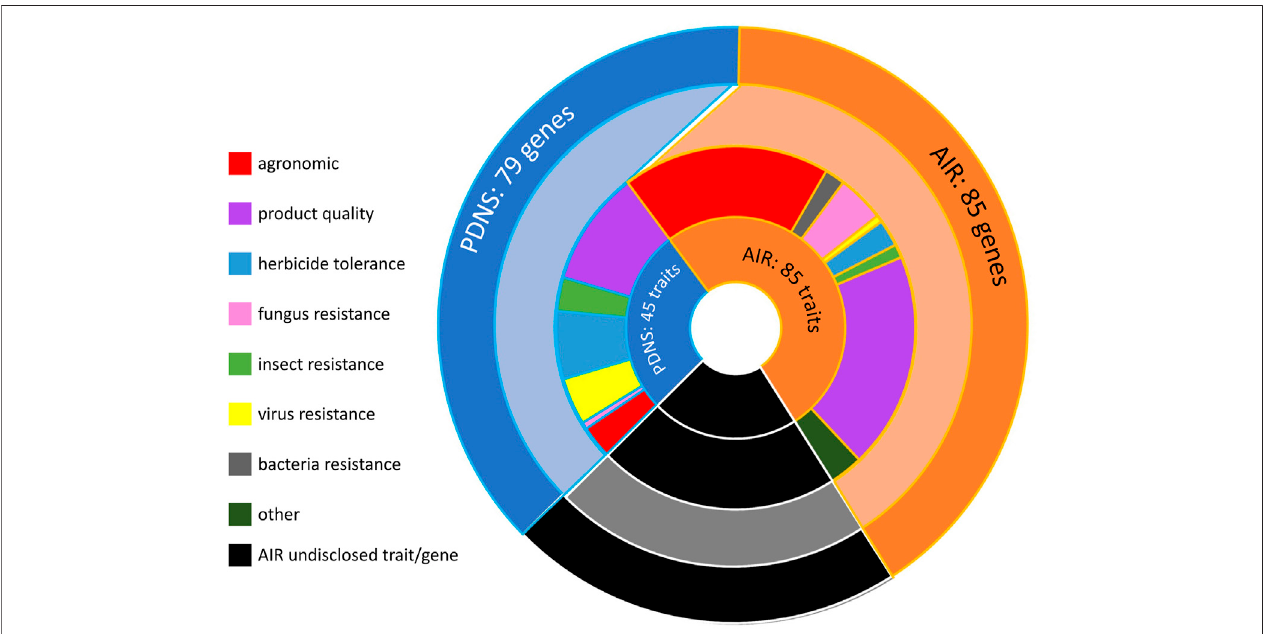
FIGURE 2 | The distribution oftraits, trait categories, and total genes across all AIR and PDNS submissions. The innermost ring shows the number of unique traits engineeredinsubmissionstoeach pathway. Thenext-innermost ringshowsthenumberofuniquetraits engineered ineachtrait categoryacrossthetwopathways, and theoutermostringshowsthetotalnumberofuniquegenesengineeredacrossallsubmissionstoeachpathway.AIRsubmissionsinwhichthegeneortraitofinterestwas redacted are represented in black. By their nature it is not possible to know the exact number of redacted genes or traits; this section of the graph is drawn proportionally to the number of submissions containing only redacted trait information.